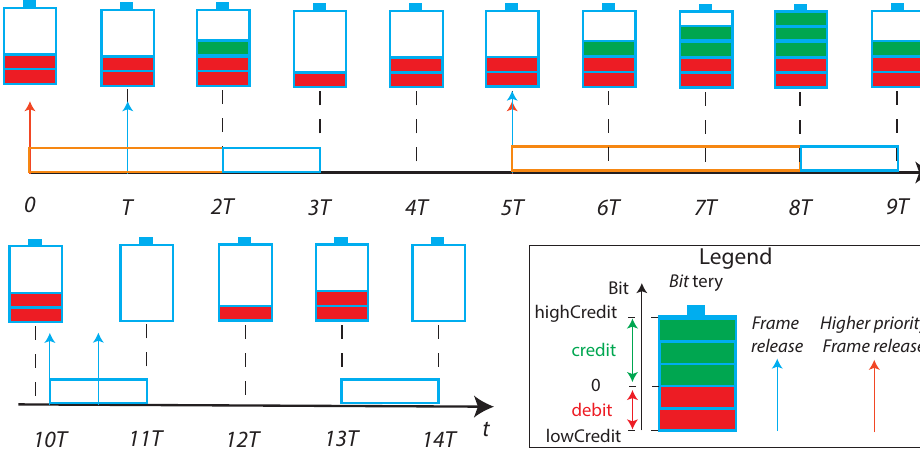
Figure 9. Credit Based Shaper